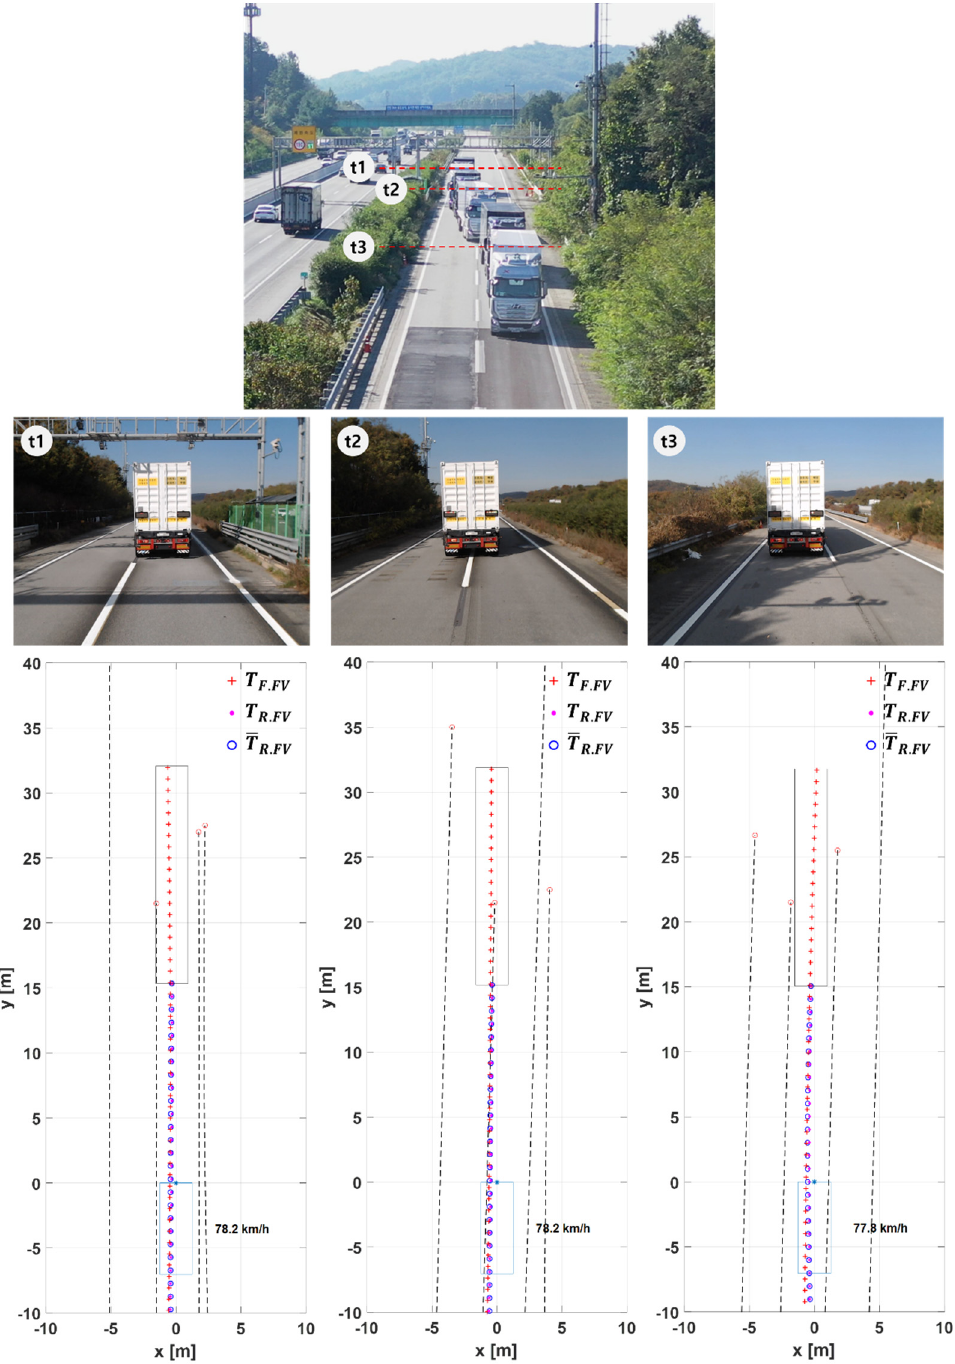
Figure 24. The test results for Scenario T2. At t1, LV initiates single lane change (SLC), at t2, FV changes lanes, and at t3, LV settles in the new lane.